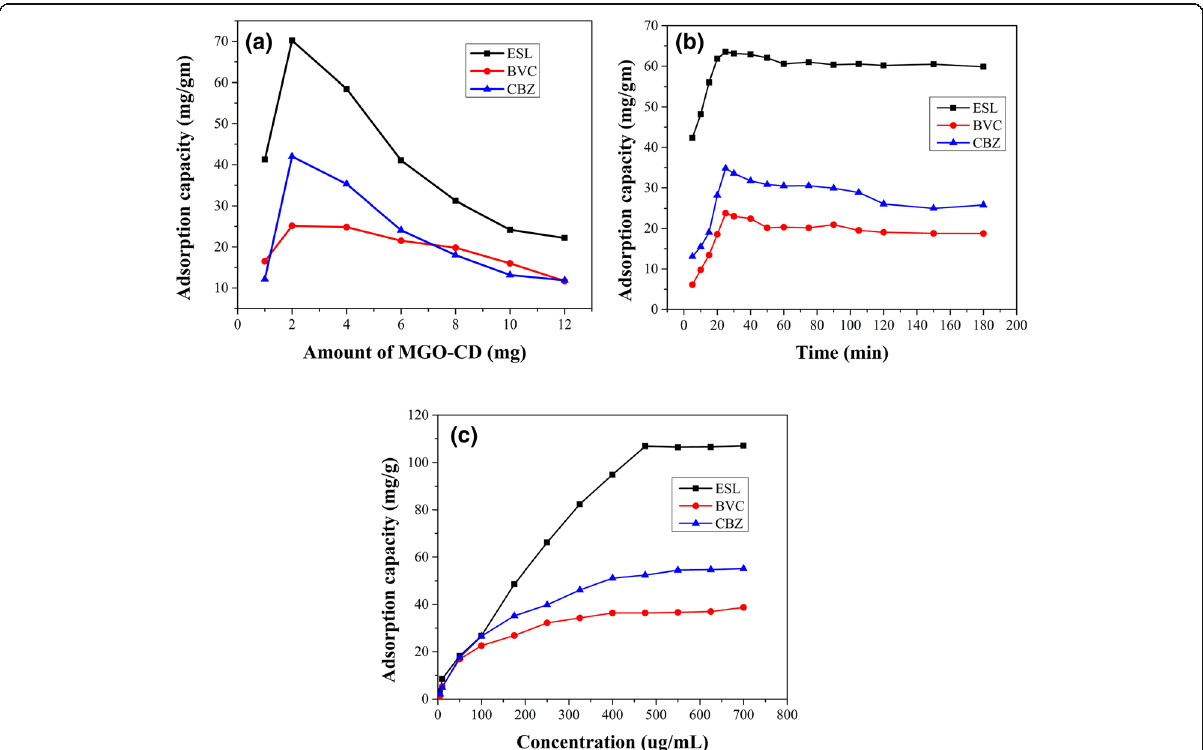
Fig. 3 a Adsorption capacity of MGO-CD. b The study of adsorption kinetics. c The study of adsorption